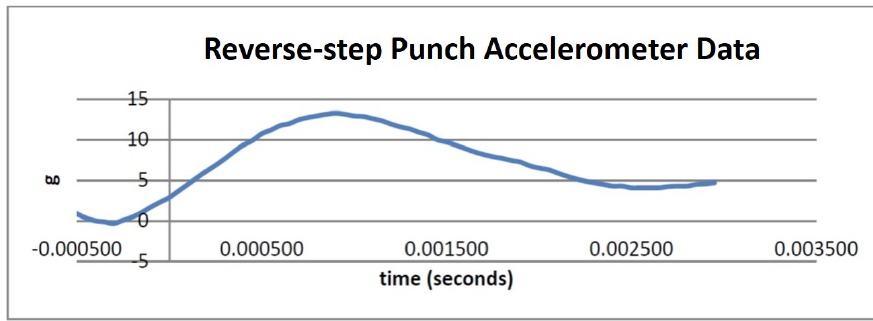
Figure 8. Reverse step punch accelerometer